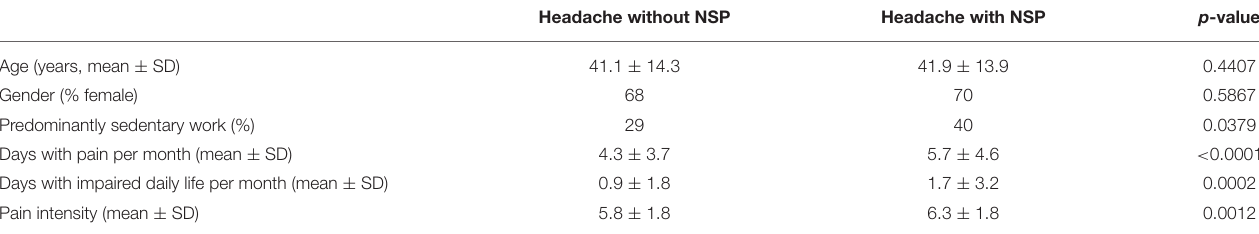
TABLE 1 | Baseline characteristics of headache